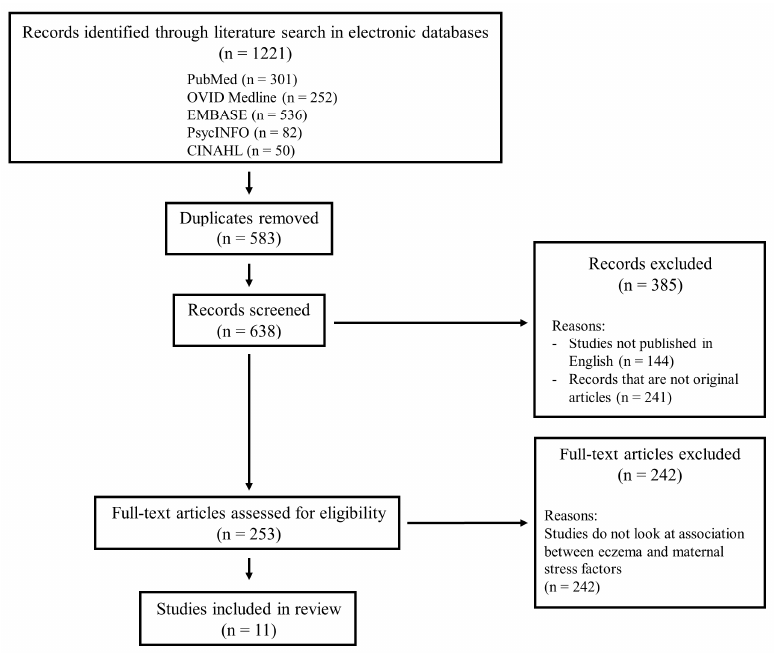
Figure 1. The PRISMA flow diagram.